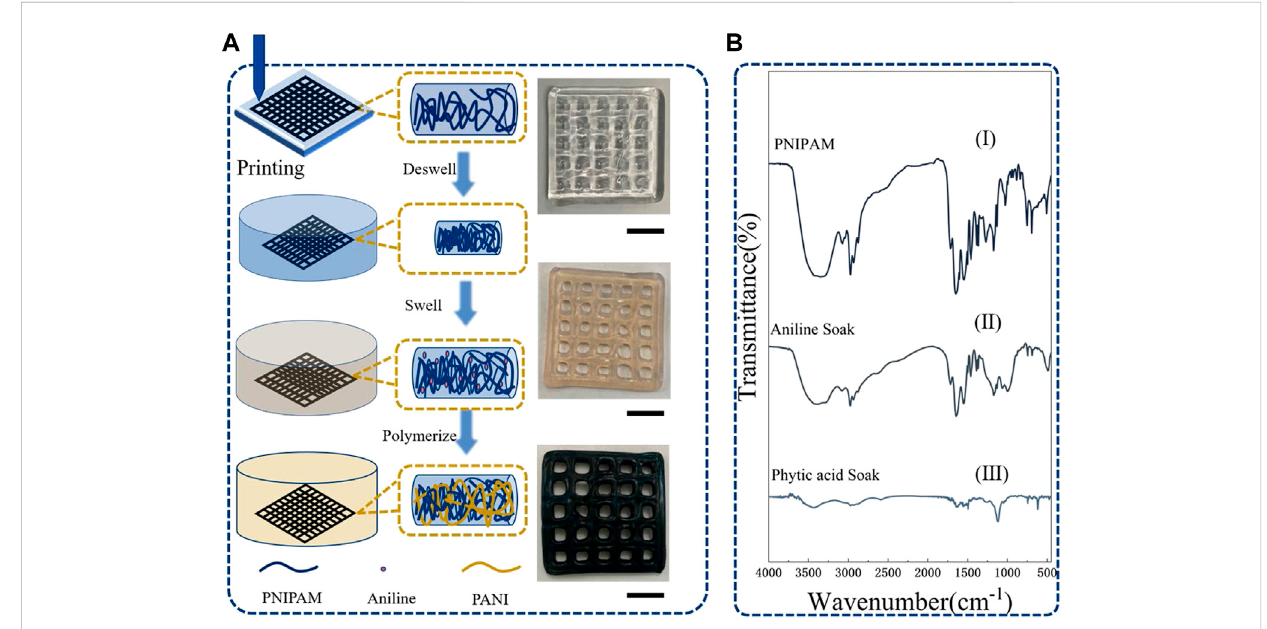
FIGURE 1 (A) The preparation process of hybrid gel, (B) FTIR spectra of different stages of gel, the ruler is 1 cm.